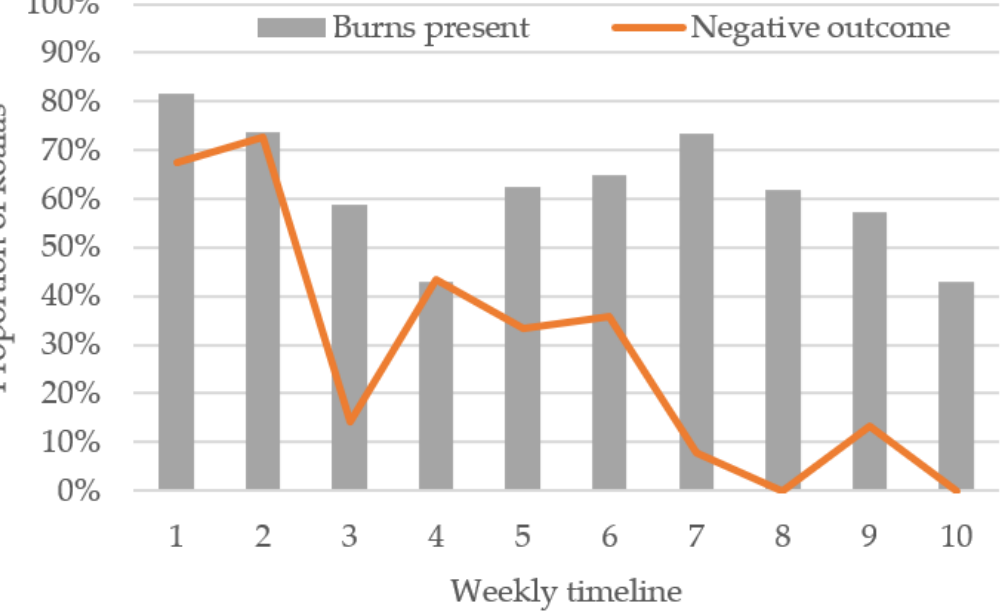
Figure 5. Weekly proportion of koalas with burns as triage progressed, and weekly proportion of koalas with negative outcomes.